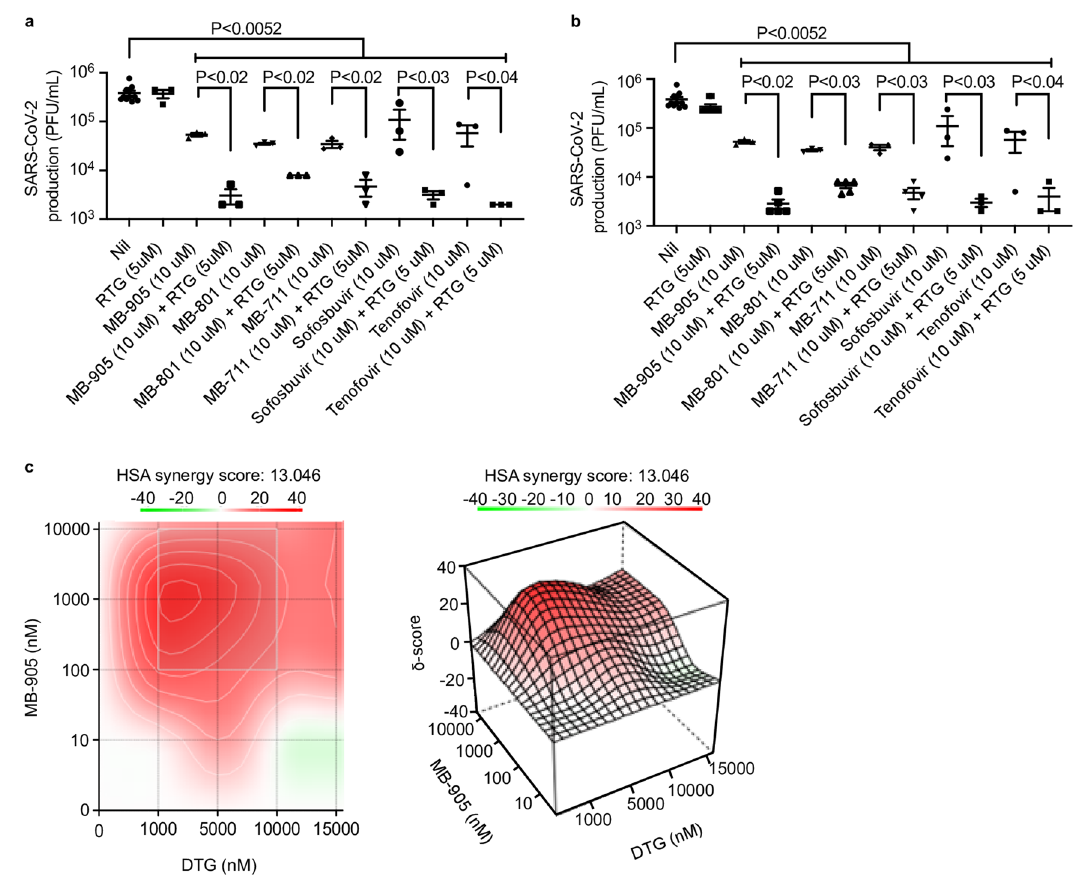
Fig. 3 | Synergistic inhibition of SARS-CoV-2 replication through combination of MB-905 and repurposed viral exonuclease inhibitors. Infected calu-3 cells weretreatedwiththeindicatedconcentrationsofMBswithraltegravir(RTG)( a )or dolutegravir(DTG)( b ),followedbytitrationinVerocells.Ordinaryone-wayANOVA test was used to compare Nil vs the other groups, P =0.0052 represents the mini- mum statistical signi fi cance, between Nil and sofosbuvir. For speci fi c comparisons